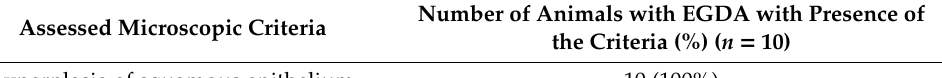
Table 3. Incidence of the selected microscopic criteria in esophageal mucosa of rats 10 weeks after esophagogastroduodenal anastomosis (EGDA)-inducing